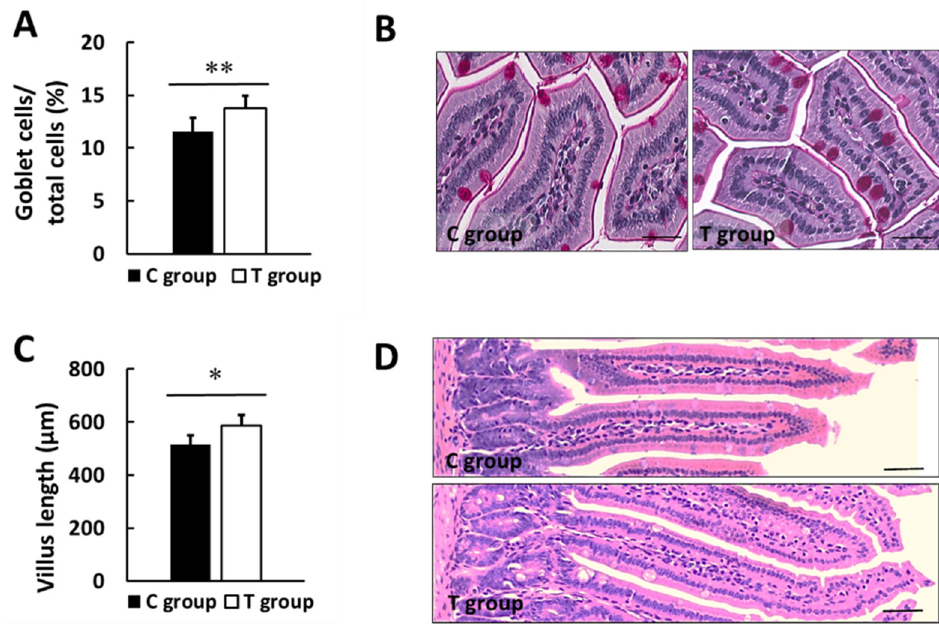
Figure 6. Intestinal histology. ( A ) Goblet cells percentage (%). ( B ) Representative images of PAS stained small intestine sections. ( C ) Length of gut wall villus. ( D ) Representative images of H&E- stained gut villus. Values are expressed as mean ± SD. * p < 0.05, ** p < 0.01. Scale bars: 25 µm ( B ) and 50 µm ( D ).